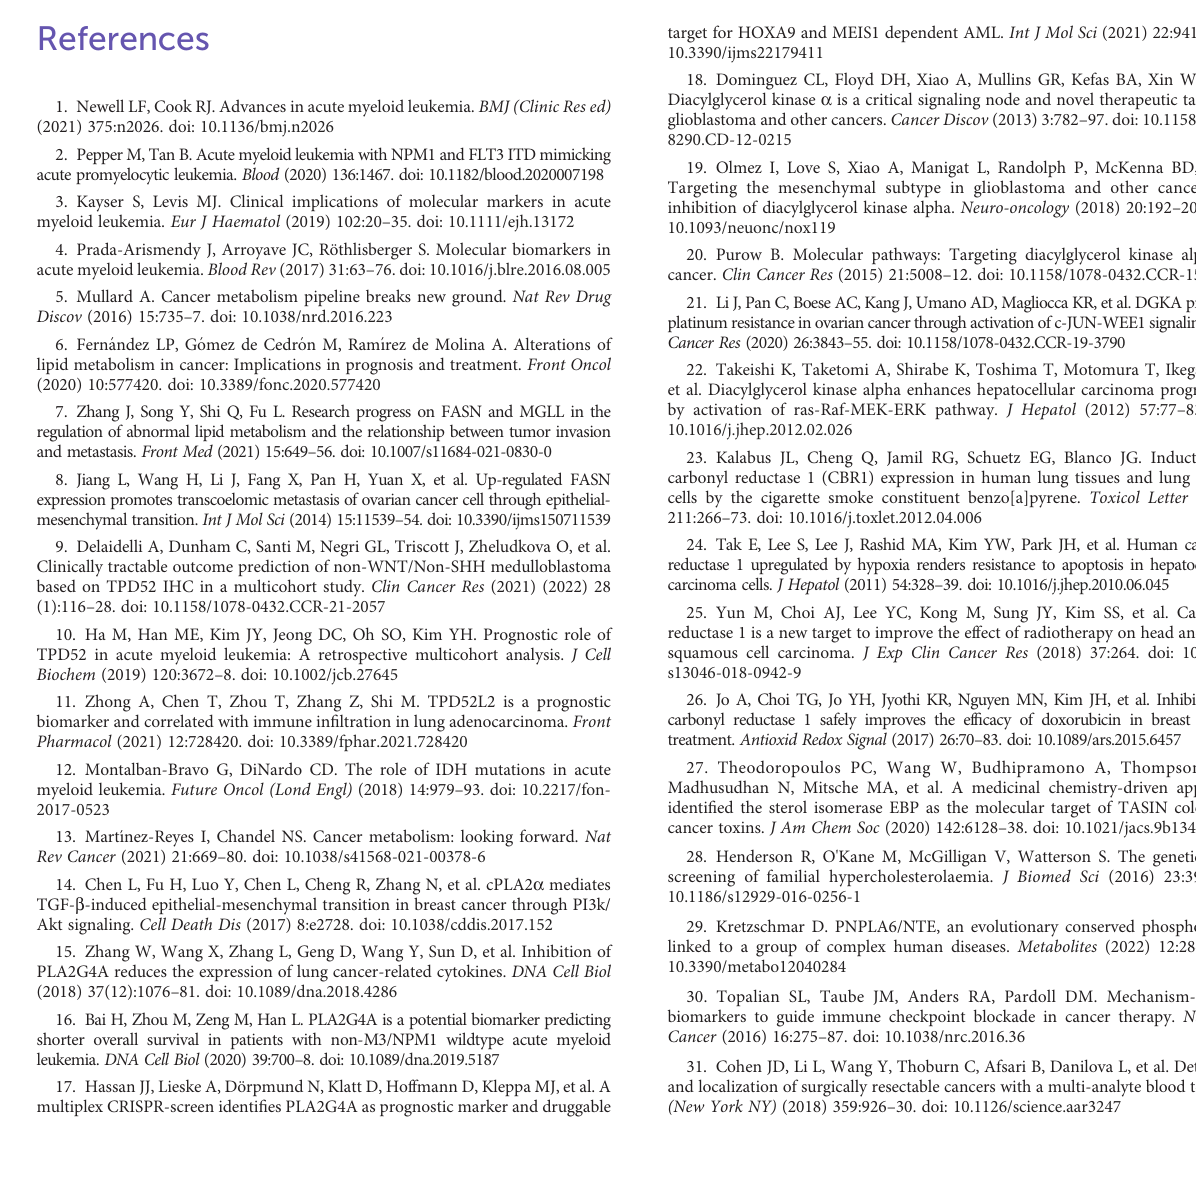
SUPPLEMENTAL FIGURE 1 Correlation of each lipid metabolism-related pathway and prognosis.